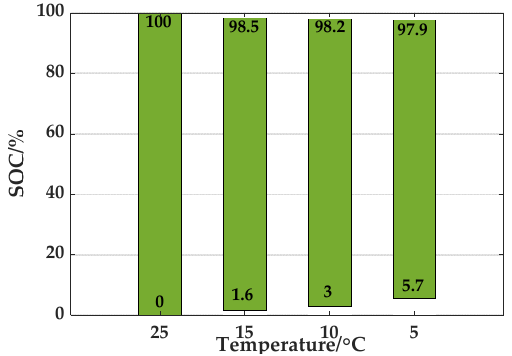
Figure 8. Identification results of each temperature parameter.